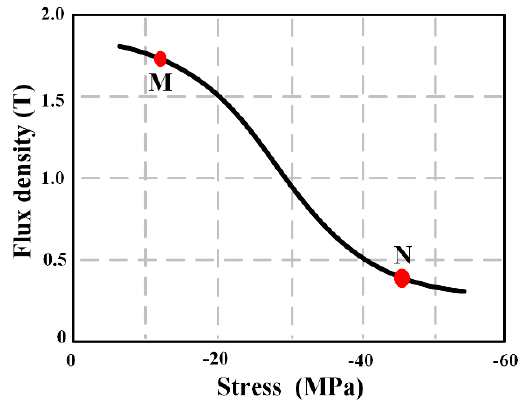
Figure 1. Sensing responses of a highly textured material under decreasing stress [30], expressed as the stress–flux density response.